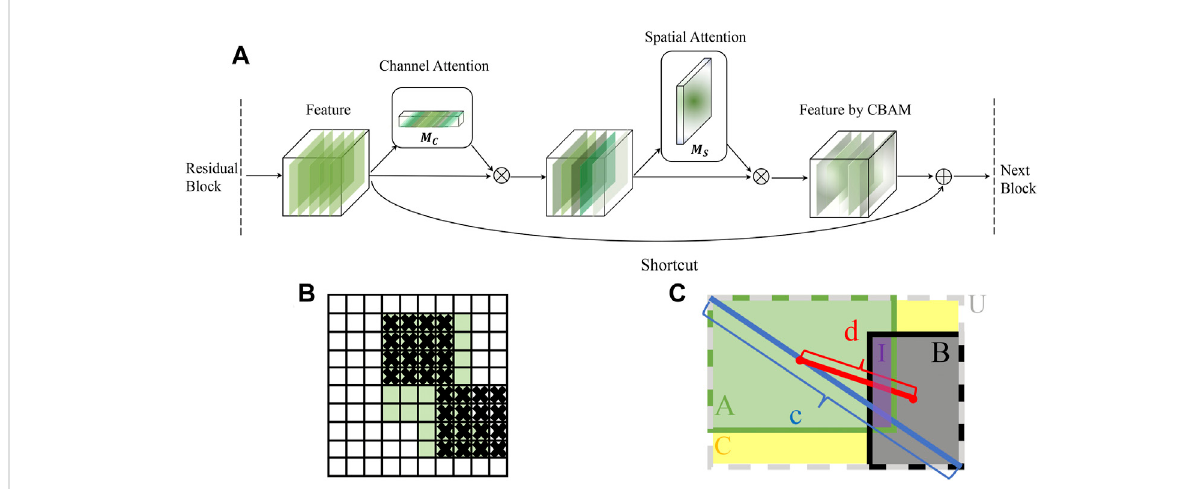
FIGURE 5 The network design of the Attention-YOLOv3. (A) Residual Block with Convolutional Block Attention Module (CBAM). (B) Diagram of Drop- Block (the white and green cells represent thenon-activated and activated neurons, respectively. The black crosses represent the dropped neurons. (C) ThediagramofCIoUwasusedasthelossfortheproposednetworkandGIOUformergence.Pleasereferthecorrespondingde fi nitionsinSection 4.3. Note that YOLOv3 is proposed to assess the detection of eighty categories in the massive ImageNet database that has millions of images (Redmon and Farhadi, 2018). In contrast, our task is a two-category detection problem to distinguish the local deformation signal from background noise with thousands of images. To avoid the over- fi tting phenomenon, we tested two strategies to decrease the complexity of the network and compare their detection effects. In the fi rst scheme, we apply regularization approaches to Attention-YOLOV3. Speci fi cally, we put the Drop-Block (Ghiasi et al., 2018) into three detection layers of Attention-YOLOv3, which is a structured form of dropout for the convolution layer. As shown in Figure 5B,theDrop-Block abandonstheneuronsintheadjacentregionsofthefeaturemaptogetherwithin acertainprobabilityto reducethe fi tting abilityofthenetwork.ThesecondschemeisthatweadoptAttention-YOLOv3-Tiny(asimpli fi edstructureofAttention-YOLOv3),whichonlyhastwo detection layers and shallower layers of backbone to deal with our